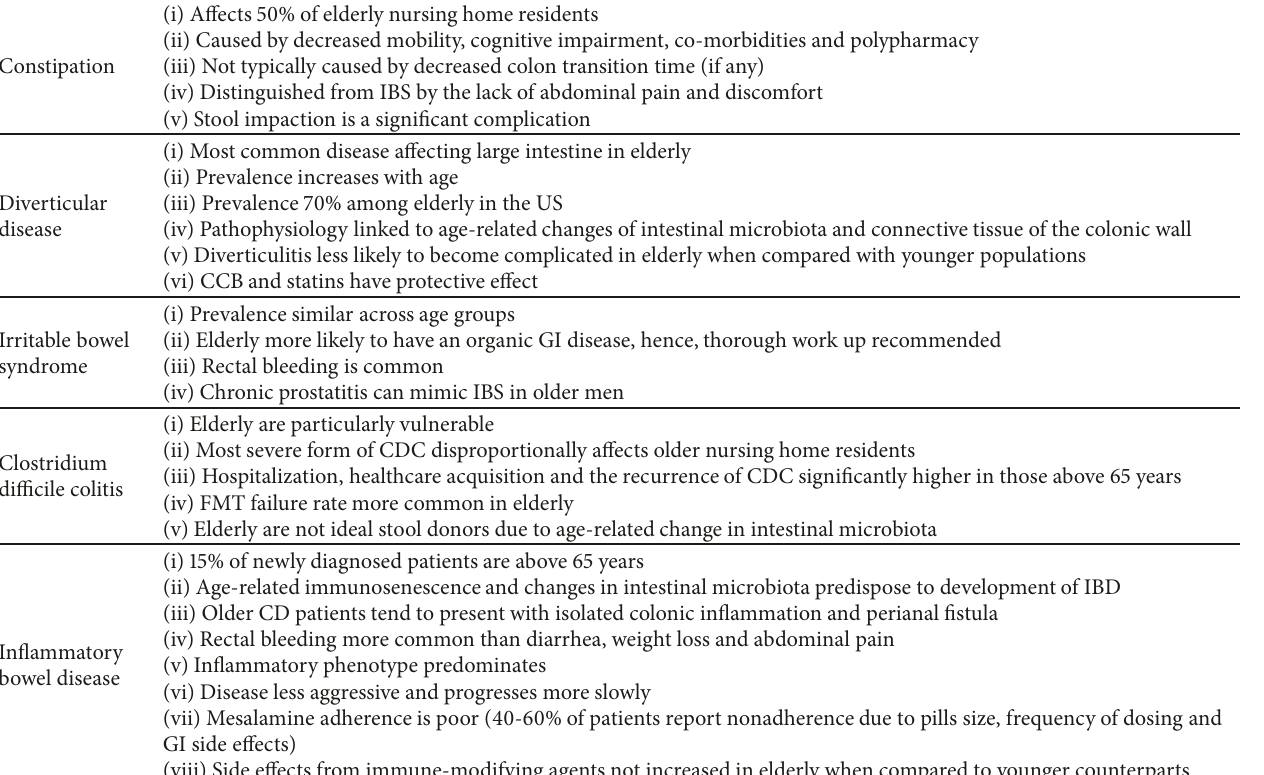
Table 5: Large intestine disease characteristics in older